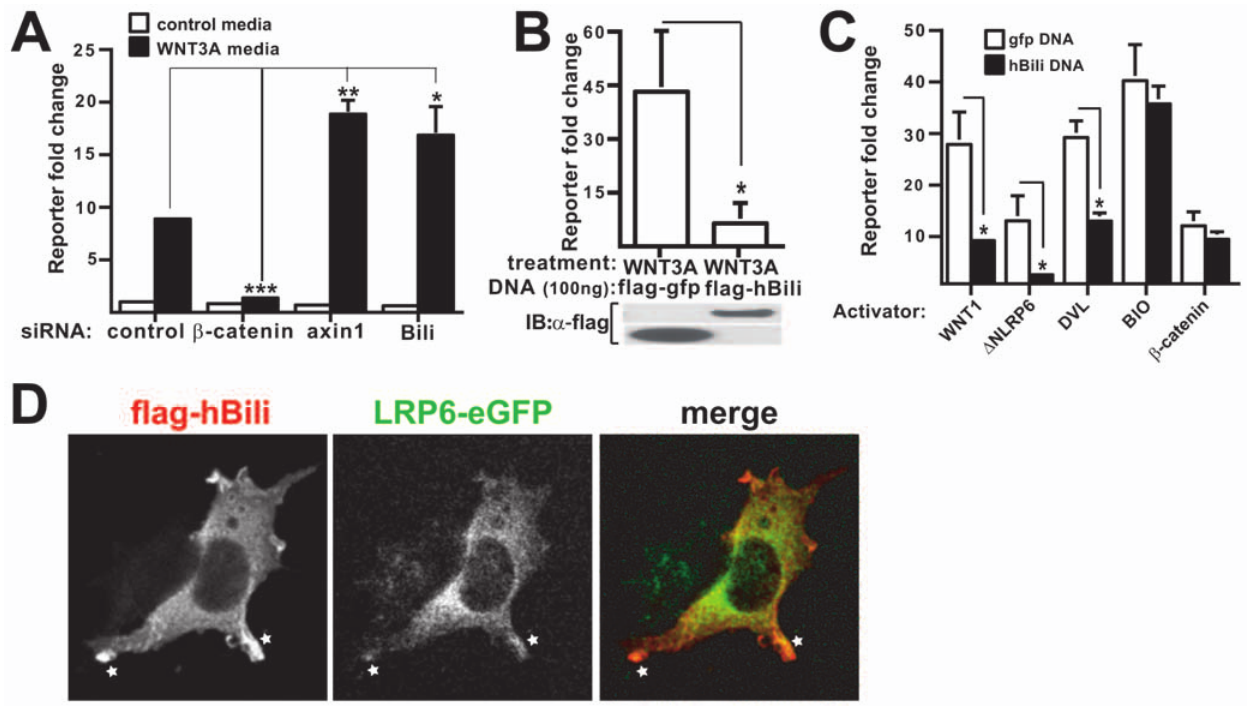
Figure 4. Bili inhibits Wnt/ b -catenin transcriptional reporters in human cell-lines. (A) Pretreatment with Bili or Axin1 siRNA leads to a 2-fold greater activation of a b -catenin responsive reporter after treatment with WNT3A conditioned media (black bars) in RKO-BAR cells compared to control siRNA. b -catenin ( b -cat) siRNA ablated Wnt 3A mediated reporter activation. Error bars represent STDEV. (B) hBili overexpression inhibits Wnt3A mediated b -catenin responsive reporter activation in HEK293T cells. (C) hBili overexpression inhibits WNT1, D NLRP6, and DVl, but not BIO, or b -catenin mediated b -catenin responsive reporter activation in HEK293T cells. HEK293T cells stably expressing a b -catenin responsive luciferase reporter were transfected or treated with WNT1, D NLRP6, DVL, BIO, or b -catenin along with GFP or Bili. Error bars represent STDEV. (D) Bili colocalizes with LRP6. HEK293T cells were transfected with flag-hBili and hLRP6-eGFP and imaged. (*p , 0.05, **p , 0.005, ***p , 0.0005)